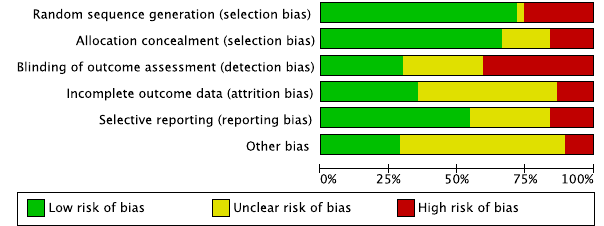
Figure 2. Methodological quality